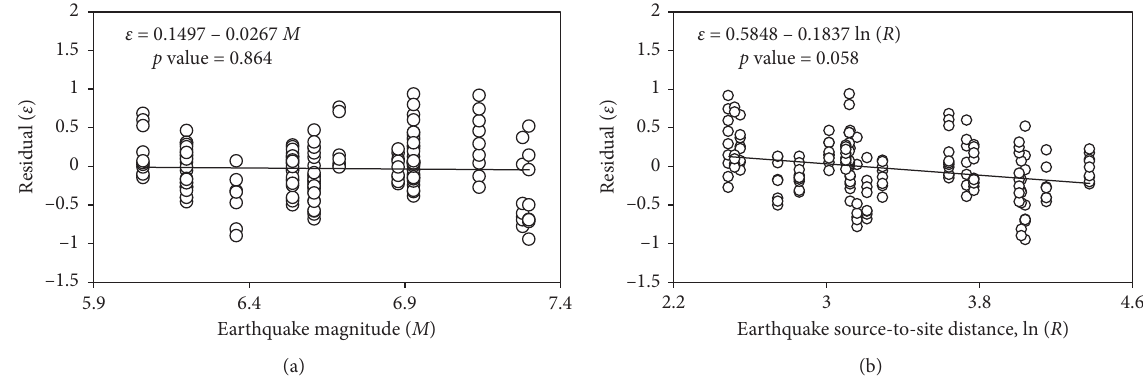
Figure 7: Sufficiency of S